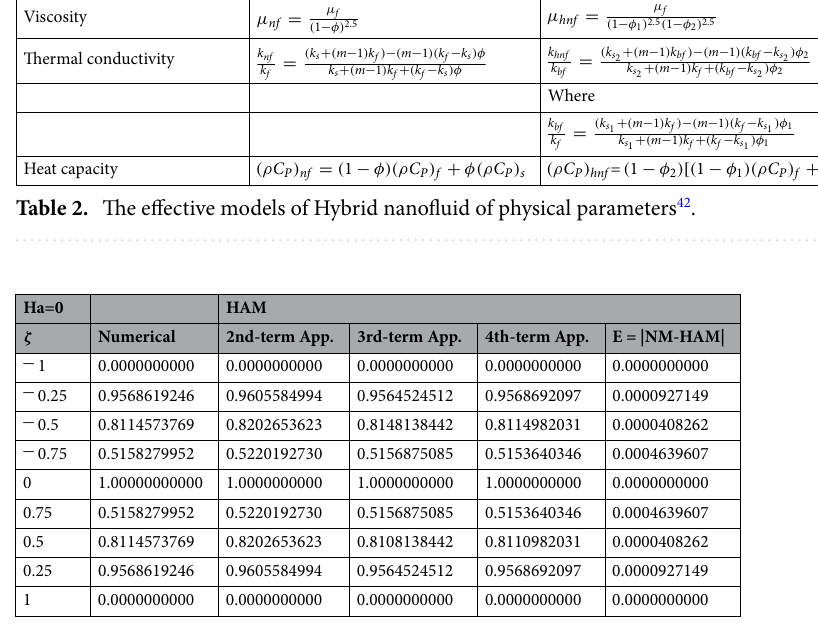
Table 3. Comparison between of numerical 31 and applied method for converging channel υ(α , δ , ζ) , when Re = 50, Ha = 0, ω = − 3 0 , α = 0, δ = 1, h = − 1 for Cu-H 2 O nanofluid.